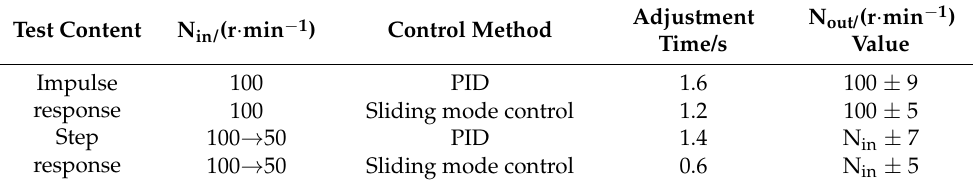
Figure 6. Response Curve of Pulse Signal. Table 1. Comparison of System Output under Test